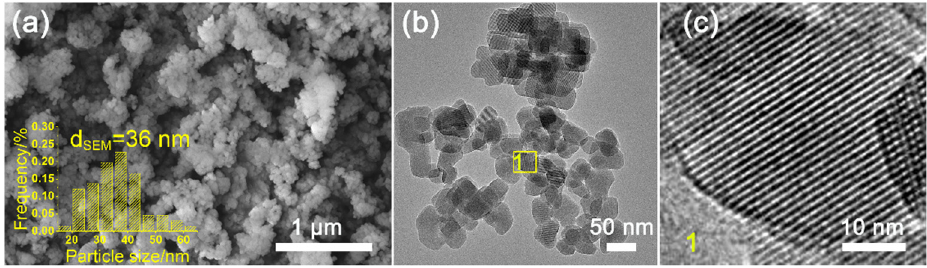
Figure 9. ( a ) SEM and ( b ) low–magnification TEM images of Z5-PK3-1 (inset: the corresponding particle size distribution); and ( c ) high–magnification TEM image of region 1 in ( b ).